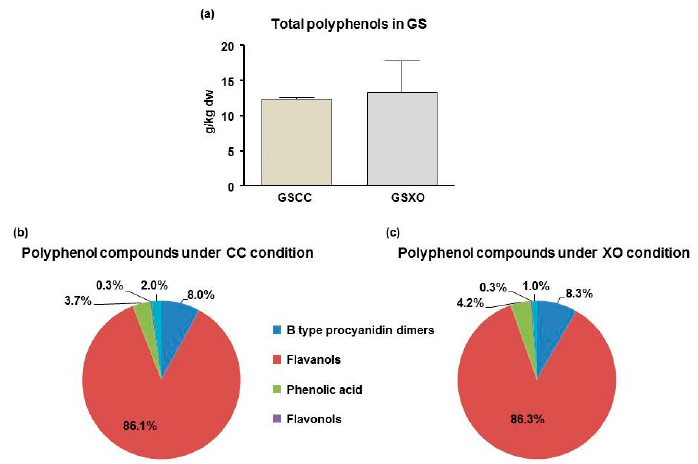
Figure A1. Polyphenol content in apple samples. Histograms represented content of ( a ) total polyphenols, expressed as g / 100 kg of dried weight (dw) fruit and the pie charts ( b , c ) represented the percentage of compounds found in the samples: flavanols, B type procyanidins dimers, phenolic acid, dihydrochalcones, flavonols in different GS variety under CC and XO conditions.